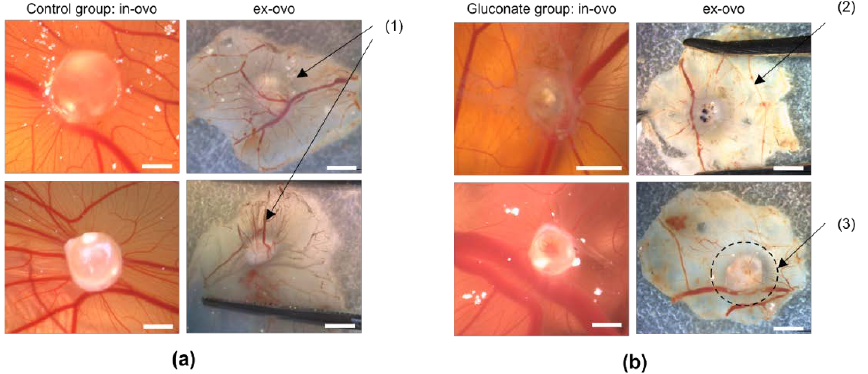
Figure 6. Effect of sodium gluconate on angiogenesis of AS-M cell line tumors on the CAM. ( a ) Microscopic images as well as photographs of untreated tumors grafted onto the CAM. The arrow marks the dense and radiant vascularization of the tumors on the bottom side after removal from the CAM. The white bar indicates 2 mm. (1) indicates that the CAM surrounding the tumor is densely vascularized. ( b ) Microscopic images as well as photographs of tumors that were treated with sodium gluconate after engraftment on the CAM. The arrows mark the absence of blood vessels surrounding the tumor on the bottom side after removal from the CAM, which corresponds to the area where sodium gluconate was applied to (3). (2) indicates rudiments of thin blood vessels that previously supplied the tumor. The vessel rudiments appear to be atrophic.